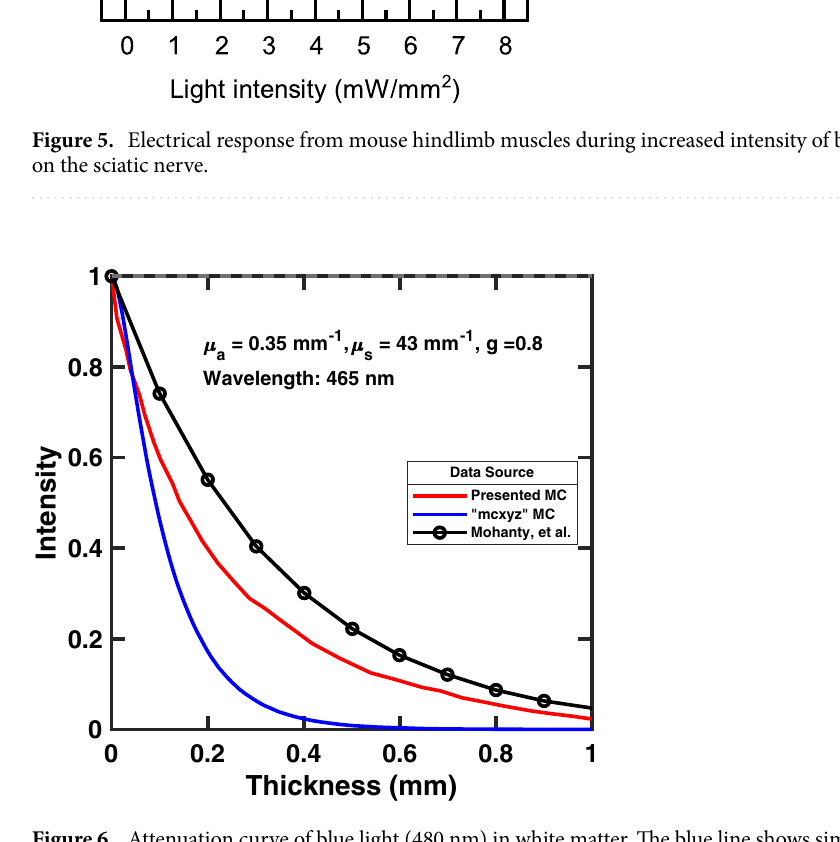
Figure 6. Attenuation curve of blue light (480 nm) in white matter. The blue line shows simulation data of 10k rays, initialized as a collimated beam which is compared against the calculated attenuation from Mohanty et al. 11